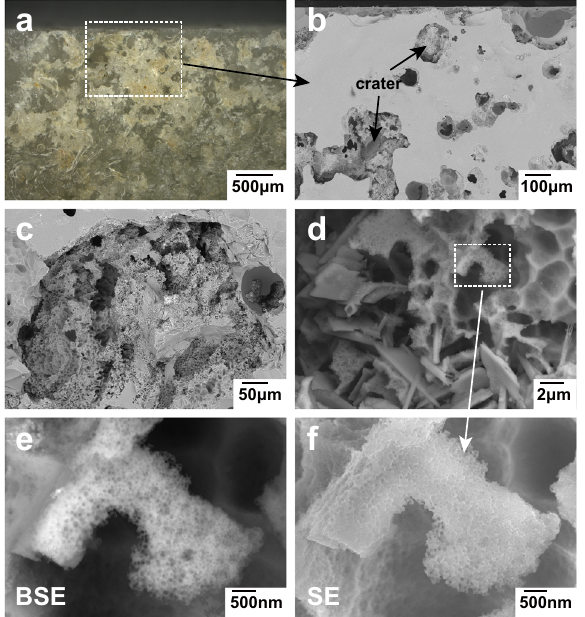
Fig. 7 Corrosion morphology of sample No. 07. a and b are the OM and SEM images of the seriously corroded region on the glaze surface, respectively; c a crater on the glaze surface; d the plate-like crystals and nearby phase-separation structure in a crater; e and f are the framed area in d : the porous glass phase, BSE backscattered electron image, SE secondary electron image.